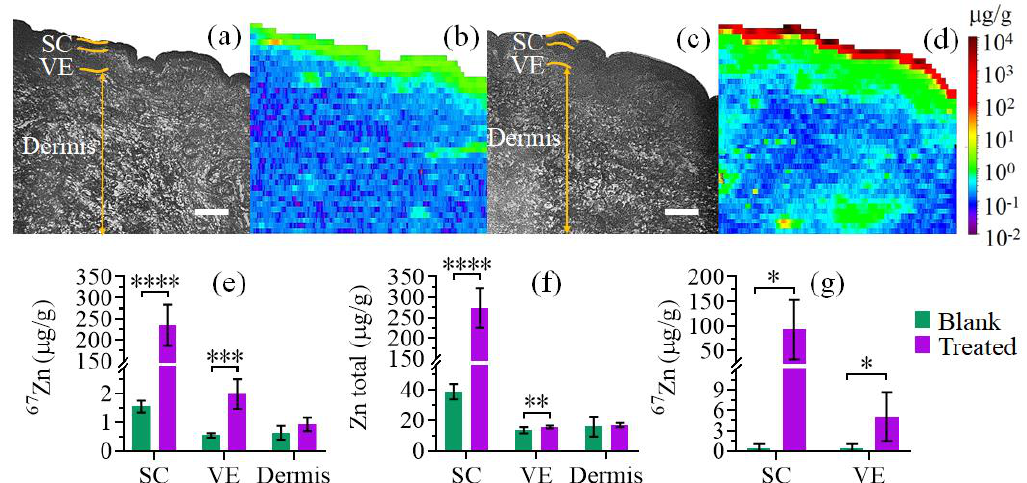
Figure 5. Results of mass spectrometry analysis of untreated and 67 ZnO-PEG NPs treated human skin samples. ( a ) Brightfield image of full-thickness freshly excised human skin section post-treatment with blank CCT formulation (Blank) for 48 h at 35 ± 1 °C. SC, VE and Dermis designate stratum corneum, viable epidermis and dermis layers, respectively. ( b ) LA-ICP-MS map of 67 Zn concentration (μg/g) of ( a ). ( c ) Brightfield image of full-thickness freshly excised human skin section post-treatment with 67 ZnO-PEG NPs (20% wt / wt ) in CCT formulation (Treated) for 48 h at 35 ± 1 °C. ( d ) LA-ICP-MS map of 67 Zn concentration (μg/g) of ( c ). ( e ) 67 Zn and ( f ) total zinc concentrations in skin measured by LA-ICP-MS for blank and treated samples. ( g ) 67 Zn concentration measured by solution-based ICP-MS for untreated and treated HSEs. (*), (**), (***) and (****) show significance difference levels at p < 0.05, p < 0.01, p < 0.001 and p < 0.0001, respectively. Data are presented as mean ± 95% confidence interval, n 3 4. Scale bars are 200 μm.